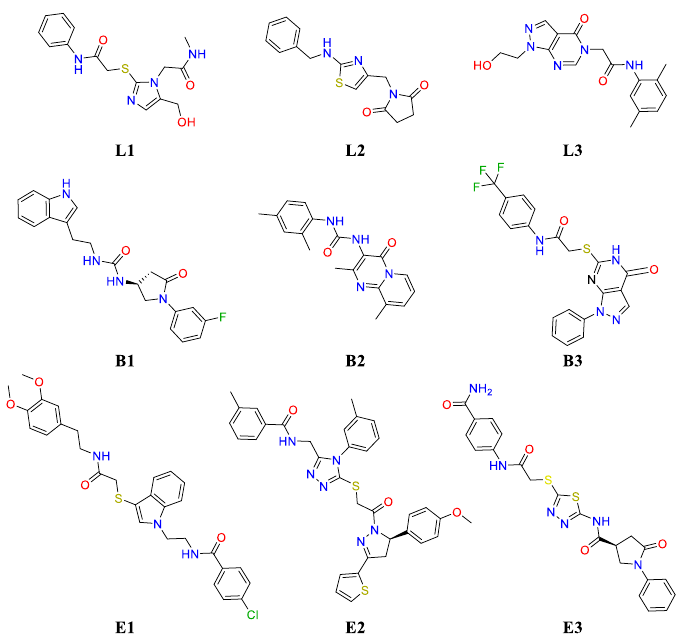
Figure 3. Molecular structure of the prioritized molecules obtained from the structure-based virtual screening (SBVS).